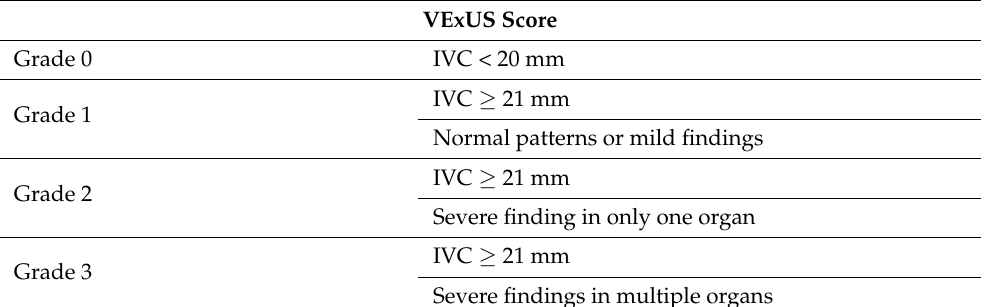
Table 2. Different grades of the venous excess ultrasound (VExUS) score obtained combining inferior vena cava (IVC) diameter and venous Doppler waveform of the portal, hepatic and interlobular renal